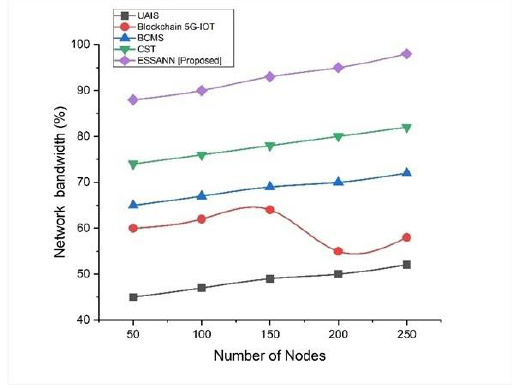
Figure 4. Comparison of network bandwidth [23 – 26].